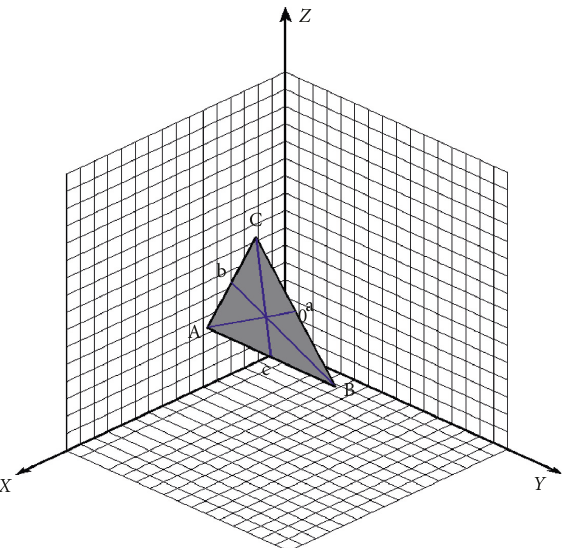
Figure 14: Subdivided triangular patch.